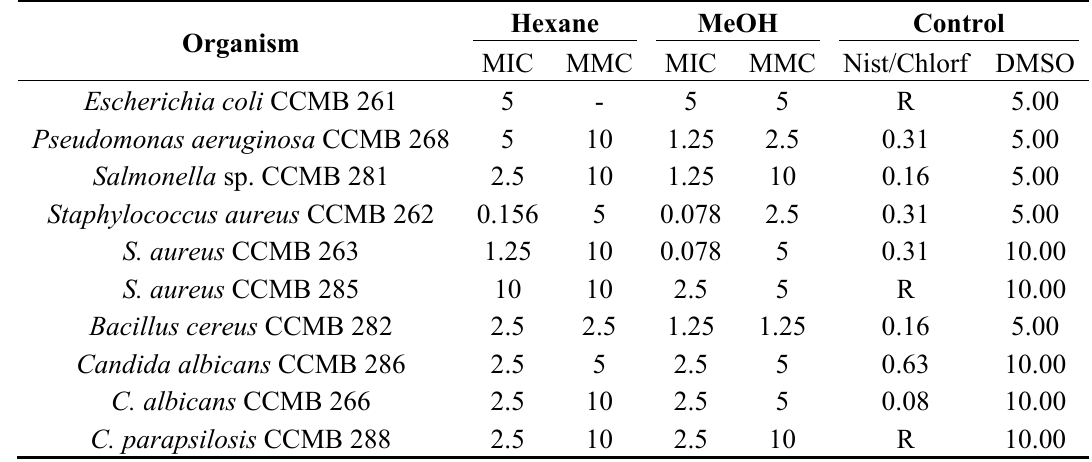
R: resistent, Nyst: nystatin, Chlorf: